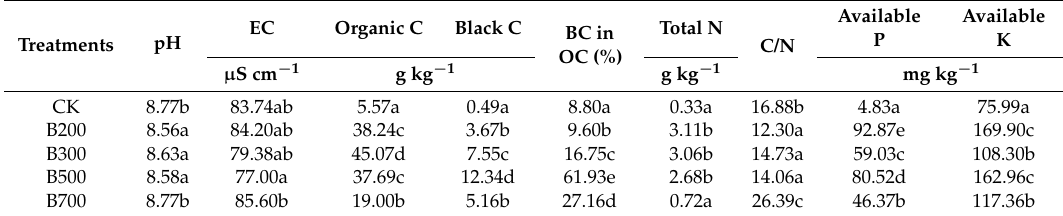
Table 3. The chemical properties of the soils amended with the biochars derived from municipal sewage sludge at 200 ◦ C, 300 ◦ C, 500 ◦ C, and 700 ◦ C for 2 h in a muffle furnace and then grown turf grass.